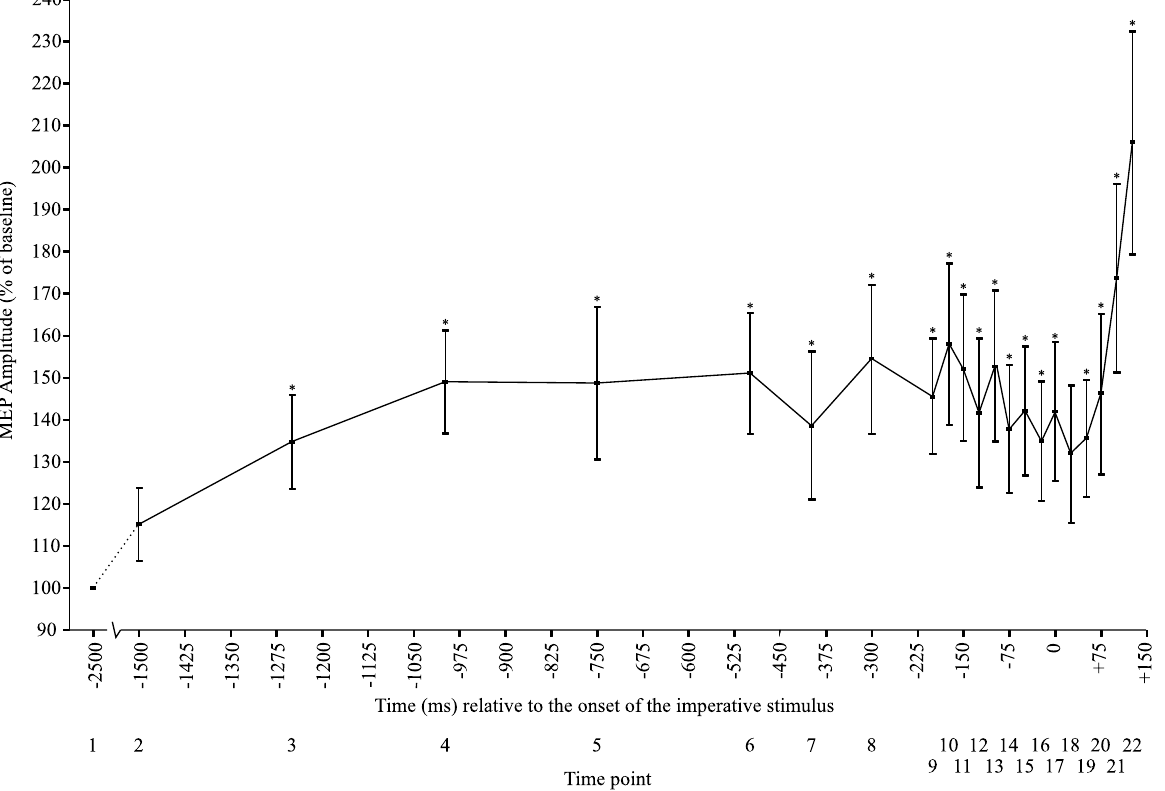
Figure 2. Mean ( + / 2 SE) motor-evoked potential (MEP) amplitude relative to the onset of the imperative stimulus expressed as a percentage of baseline.